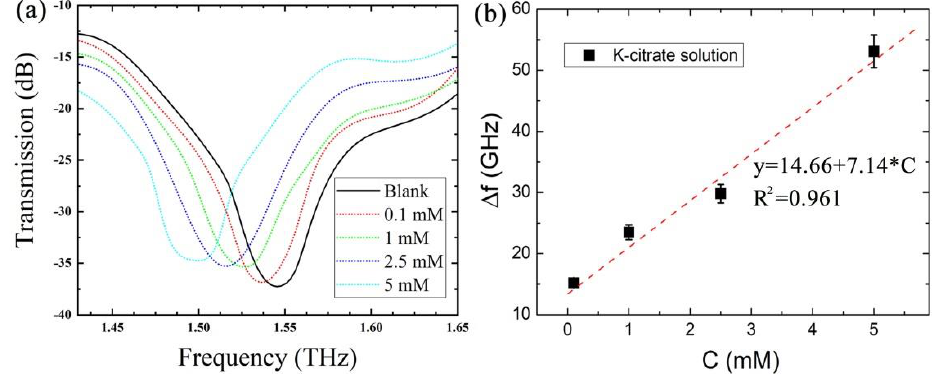
Figure 6. ( a ) Transmission spectra of the blank sensor and sensor covered by K-citrate sample at different concentrations. ( b ) Relationship between ∆ f and the K-citrate concentration with the dash line being the fitting line.